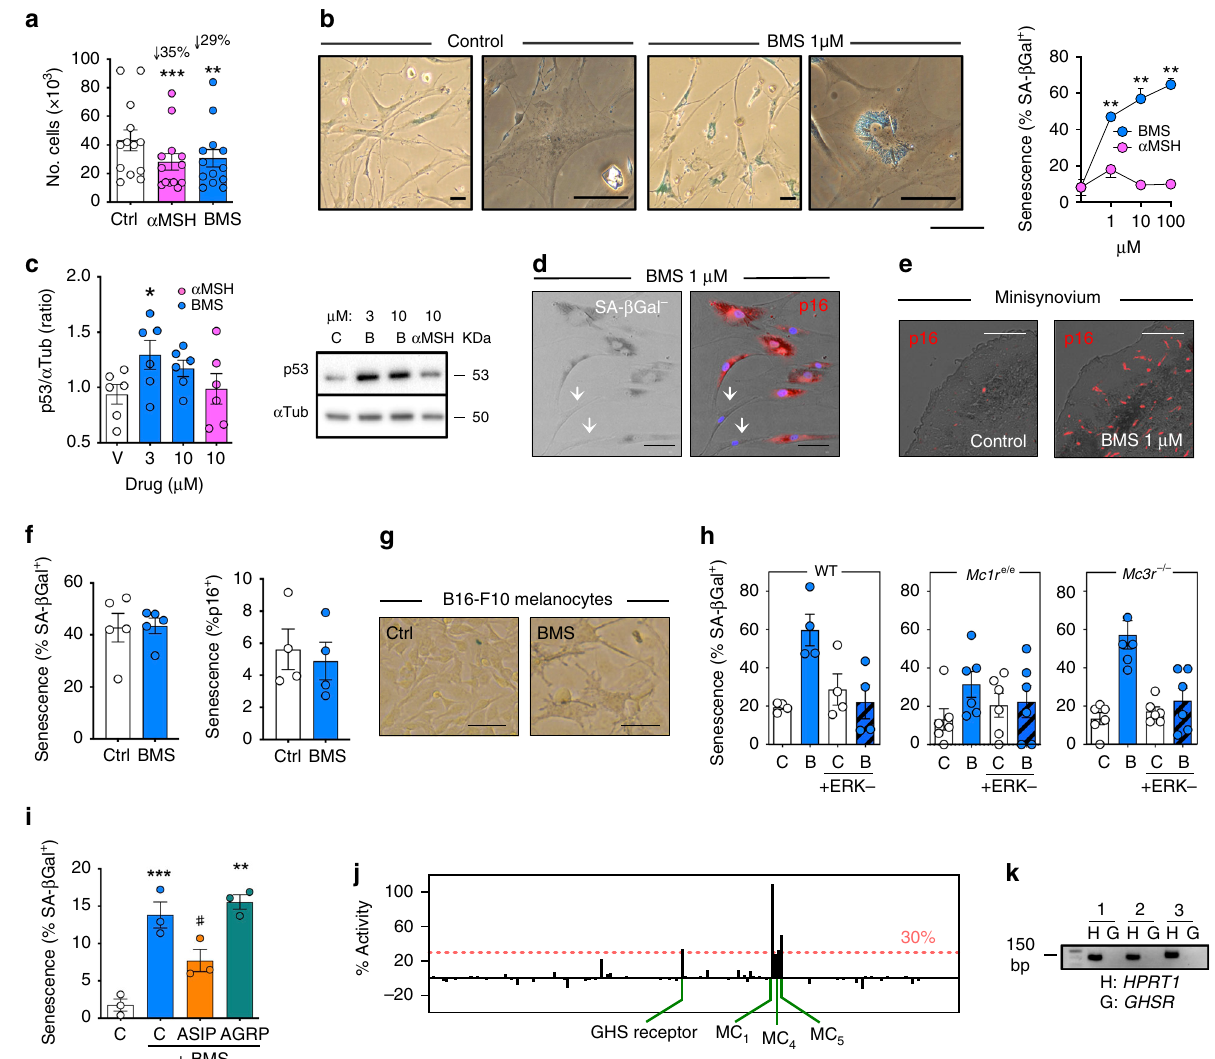
Fig. 2 Cellular senescence induced by selective MC 1 agonism. a SF cells were treated for 7 days with 10 μ M α MSH or 1 μ M BMS and proliferation assessed by cell counting. Data are mean ± SE ( n = 13, Student ’ s t -test vs. control; ** p < 0.01, *** p < 0.001). b Cells were treated with BMS or α MSH for 7 days and SA- β Gal + cells quanti fi ed. Scale bars indicate 100 μ m. Data are mean ± SE ( n = 2, two-way ANOVA; ** p < 0.01). c p53 protein levels were analyzed by western blot after 7-day treatment of SF cells with 3 or 10 μ M BMS (B) or 10 μ M α MSH and bands quanti fi ed (fold change with respect to vehicle). Data are mean ± SE ( n = 6, Student ’ s t -test vs. control, C; * p < 0.05). d Immuno fl uorescence for p16 INK4 in SF cells treated with 1 μ M BMS was performed on SA- β Gal-stained cells to determine their association. Scale bars indicate 200 μ m. e SF cells were grown on Matrigel ® -based 3D spheroids for 3 weeks with or without 1 μ M BMS. p16 INK4 was determined by immuno fl uorescence. Scale bars indicate 200 μ m. f Effect of BMS on SA- β Gal and p16 INK4 staining in human macrophages incubated with 1 µ M BMS for 7 days. Data are mean ± SE ( n = 5, Student ’ s t -test vs. control, Ctrl). g Senescence on B16-F10 mouse melanocytes (1 µ M BMS for 7 days) was determined by SA- β Gal staining. Scale bars indicate 1000 μ m. h SF were isolated from the joints of wild type (WT), Mc1r e/e , or Mc3r − / − mice and treated with 1 μ M BMS (B) and/or the ERK1/2 inhibitor FR180204 (ERK − ; 1 µ M) for 7 days. Senescence was quanti fi ed by SA- β Gal staining. Data are mean ± SE ( n = 4 – 6, Student ’ s t -test vs. control, C). i Senescence was induced in SF with 1 μ M BMS and determined by SA- β Gal staining. The MC 1 antagonist ASIP or MC 3 /MC 4 antagonist AGRP were used at 50 nM. Data are mean ± SE ( n = 3, Student ’ s t